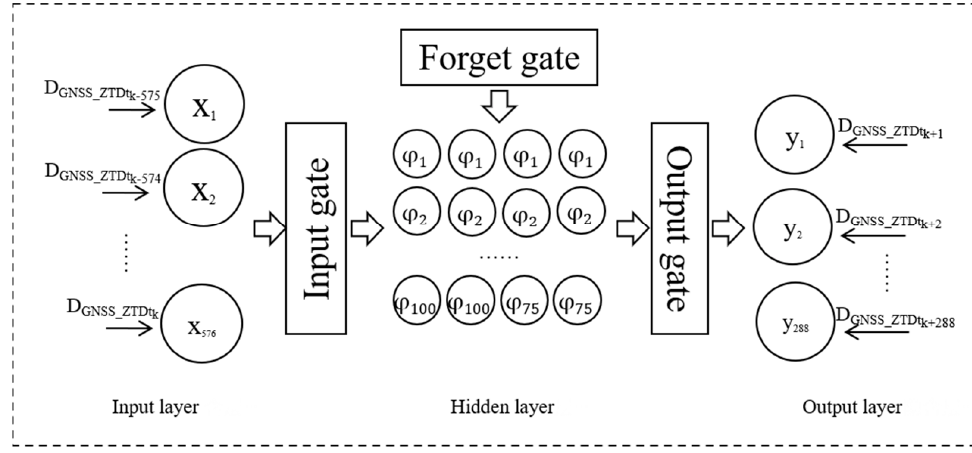
Figure 6. Structure of LSTM